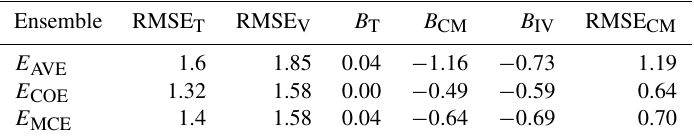
Table 5. Performance comparison of different methods on NARCLiM data; RMSE on training (RMSE T ) and validation (RMSE V ) data; and trend bias ( B T ), climatological monthly bias ( B CM ), interannual variability bias ( B IV ) and climatological monthly RMSE (RMSE CM ) on validation data.